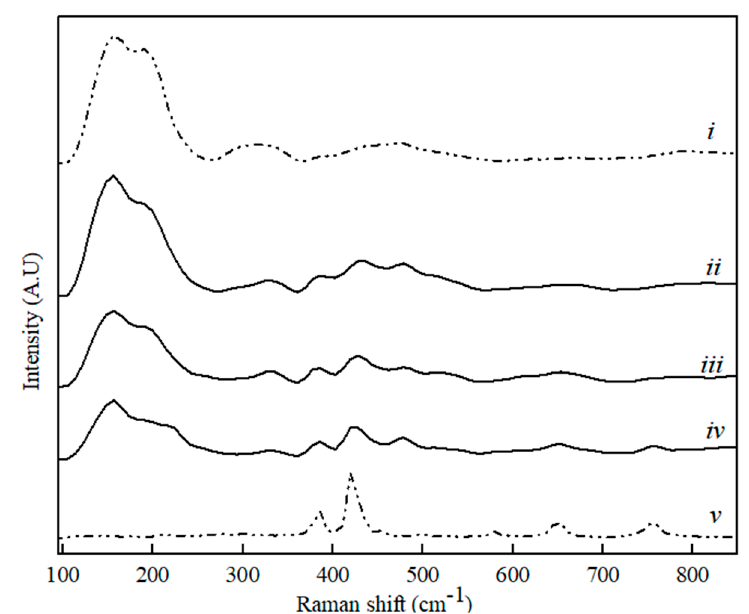
Figure 8. Raman spectra for CaS ( i ), Al 2 O 3 ( v ) and binary CaS–Al 2 O 3 phase sample with CaS content, where ( ii ) 80 wt. %, ( iii ) 60 wt. %, and ( iv ) 20 wt. %.